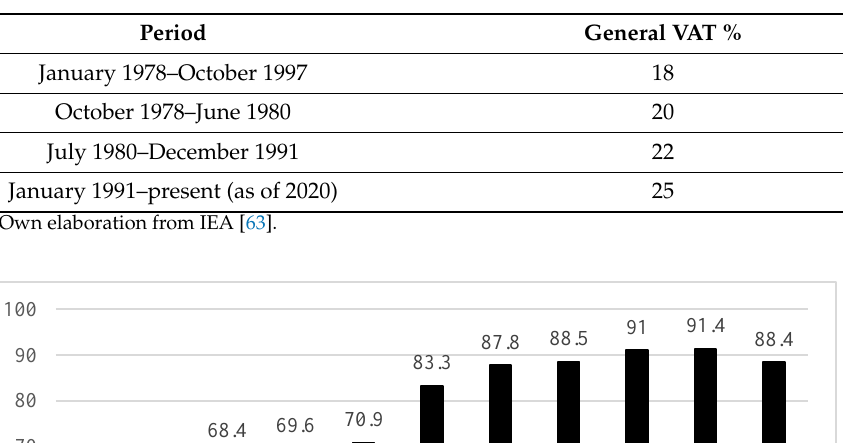
Table 4. VAT of Denmark, 1978 to 2020.